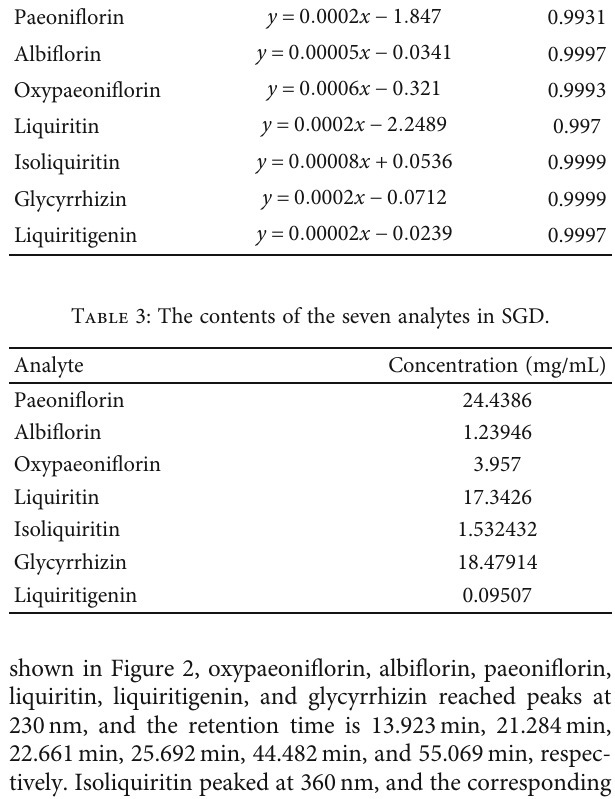
Table 2: The regression equations of seven analytes in SGD. Analyte